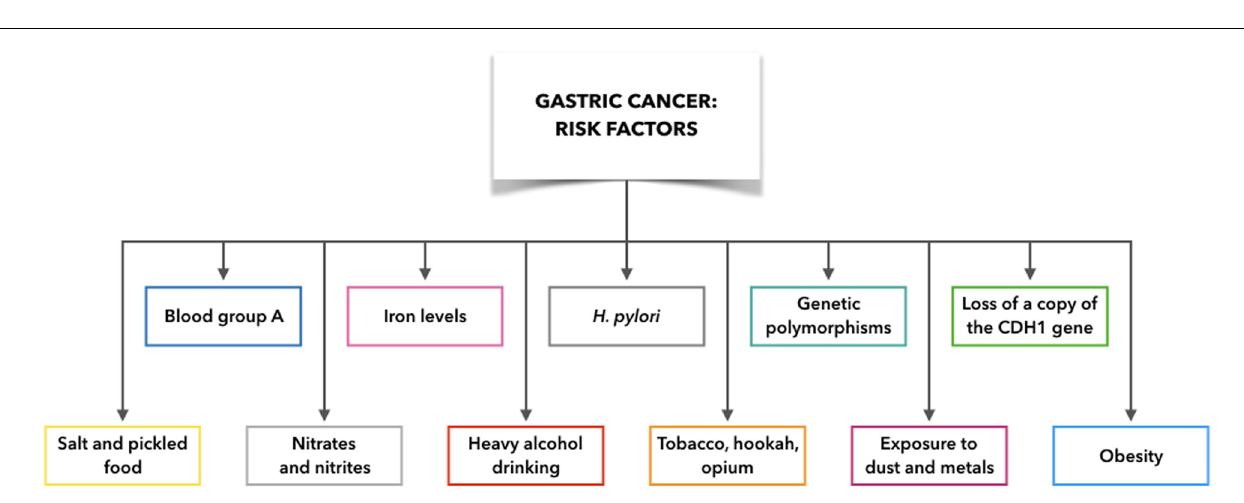
These results indicate that genetic variations in inflammation- related genes may play a role in the outcome of H. pylori infection and development of gastric